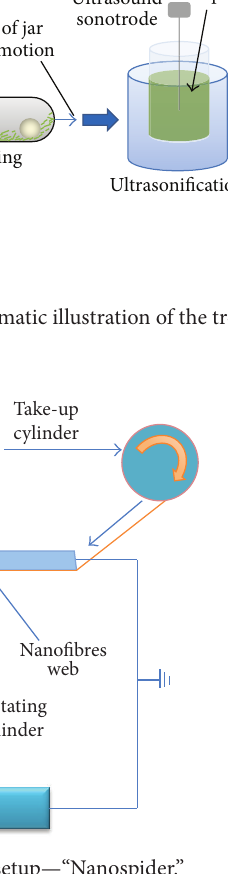
Figure 2: Scheme of electrospinning setup—“Nanospider.” Schematic illustration of fibers and shives treatments is shown in Figure